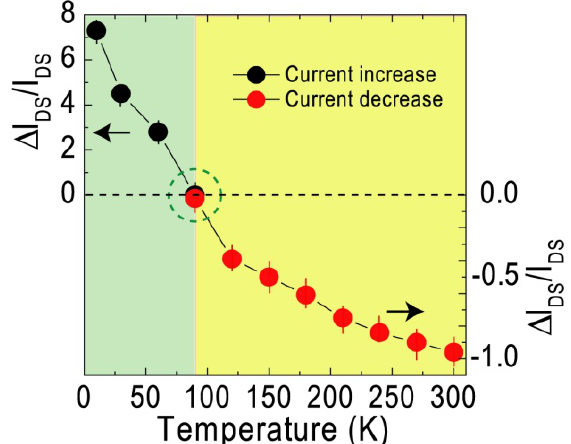
Figure 8. Variation of photoinduced current ( Δ I exposure of a light pulse (400